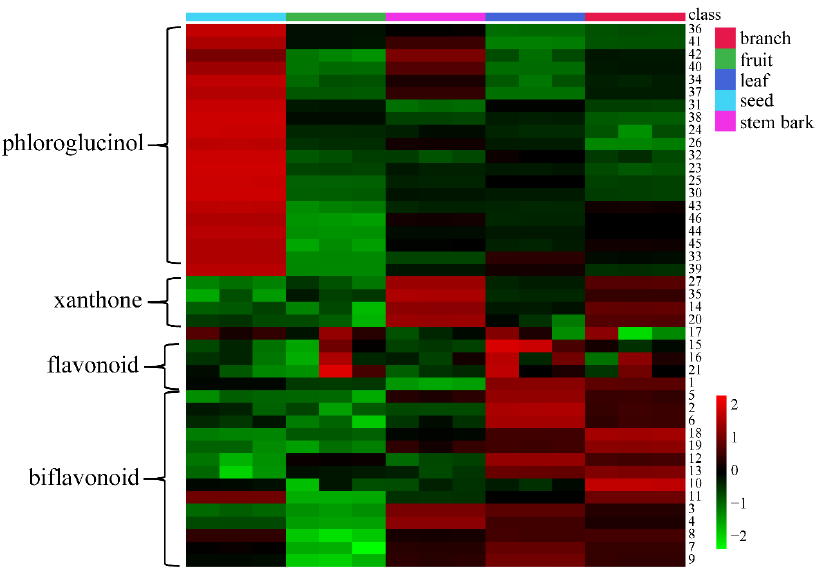
Figure 3. The heatmap presenting the distribution of metabolic profiling in the branch, fruit, leaf, seed, and stem bark extracts of G. xanthochymus . The number represents the identified metabolites in Table S1. Red color indicates a relatively high content. Blue color indicates low content of metabolites. The potential active markers of methanol extracts from different parts of G.